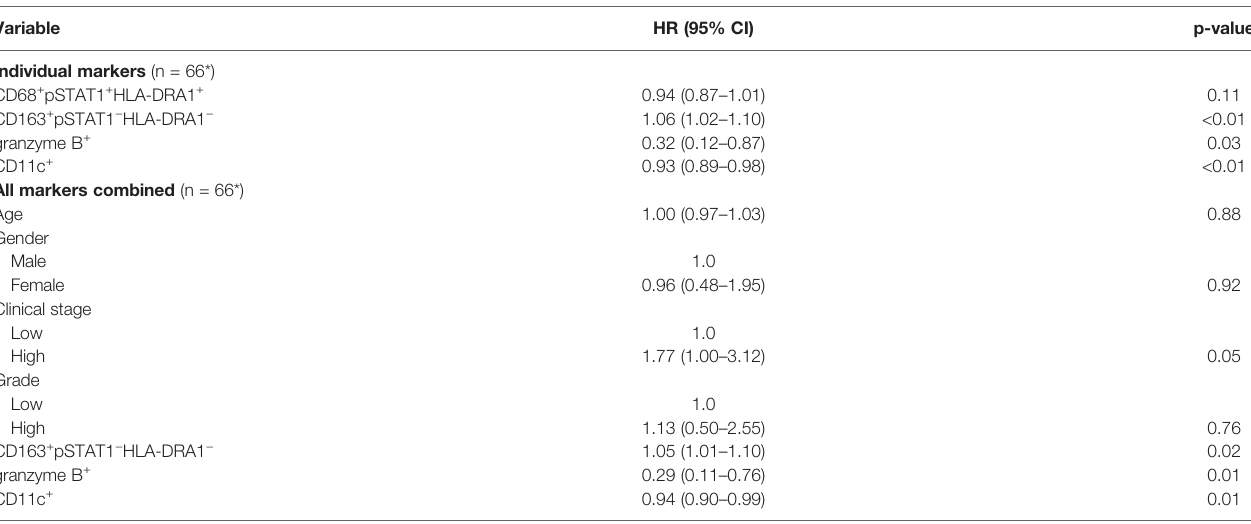
TABLE 3 | Multivariable Cox regression analysis.